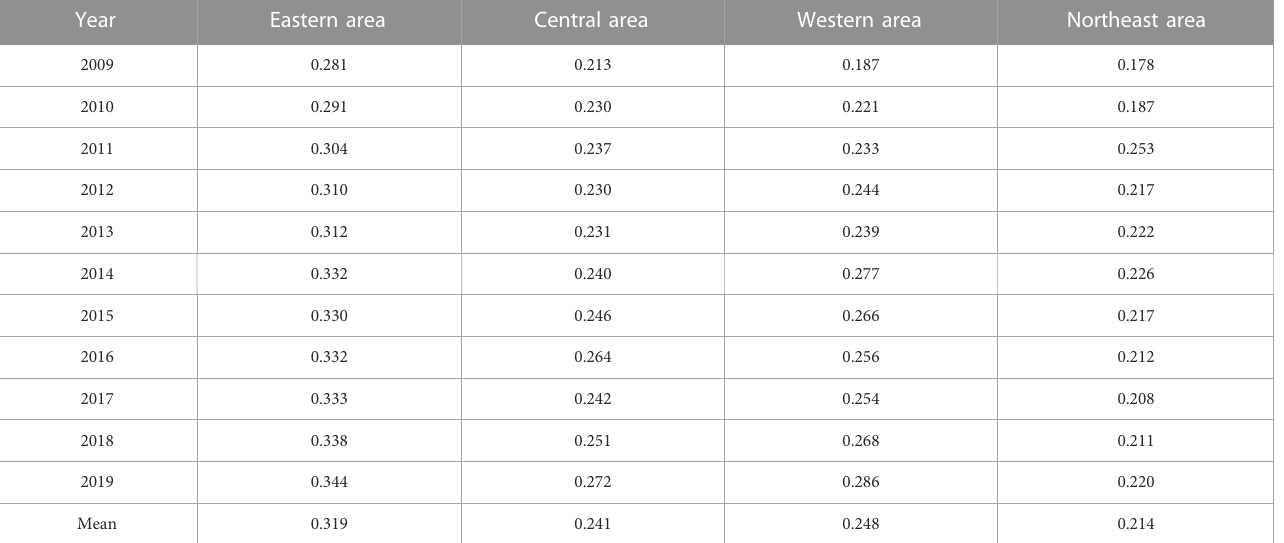
TABLE 5 Regional levels of